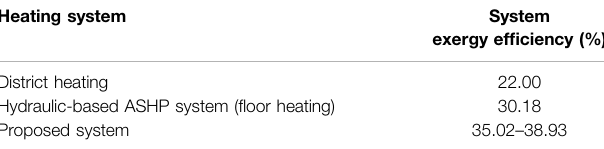
TABLE 5 | Exergy ef fi ciency comparison for different heating systems. Heating